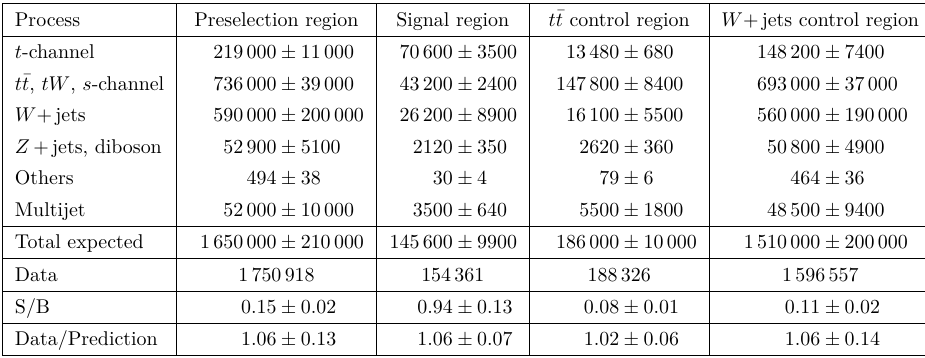
Table 3 . Pre-fit event yields in the preselection and signal regions and in the t ¯ t and W + jets control regions for the combined electron and muon channels. The predictions are derived from simulated event samples normalised to the theoretical cross-sections. For multijet production the normalisation is estimated using a data-driven likelihood fit. The label ‘Others’ represents t ¯ tZ , t ¯ tW , tZq , tHq , and tWZ production. The data-driven scale factors obtained for the top-quark and W + jets background processes are not considered when computing these event yields. The uncertainties shown account for systematic effects and the uncertainty due to limited MC sample size. The expected S/B ratio and the ratio of the observed number to the expected number of events are also